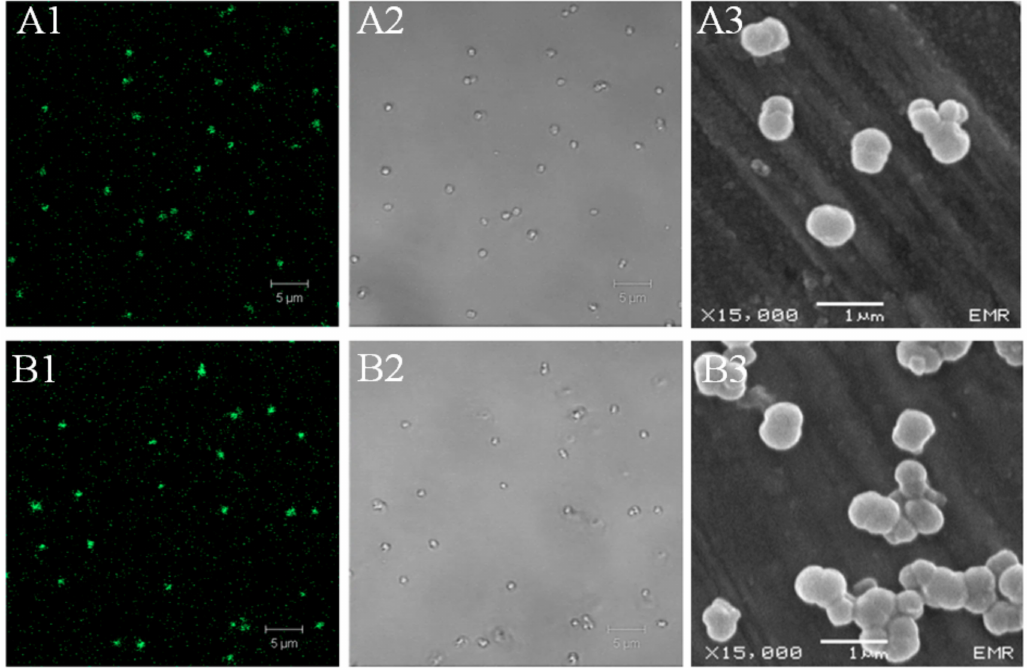
Figure 2. Microscopic images of HSA-MPs ( A1 – 3 ) and DOX-HSA-MPs ( B1 – 3 ). ( A1 , A2 ) Confocal Laser Scanning Microscopy (CLSM) images of HSA-MPs and (B1, B2) CLSM images of DOX-HSA-MPs in fluorescence mode (excitation wavelength 488 nm, long pass emission filter 515 nm) and transmission mode, respectively; ( A3 , B3 ), SEM images of HSA-MPs and DOX-HSA-MPs,